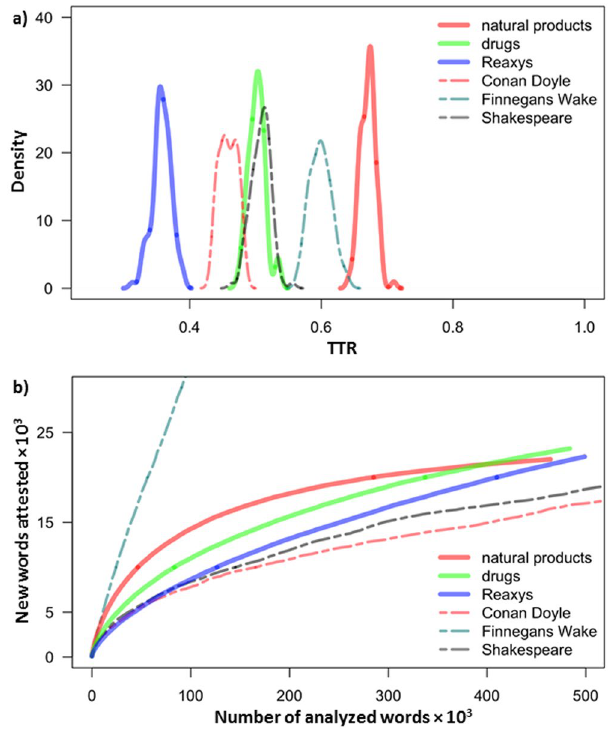
Figure 2. Measures of chemical diversity in chemistry and in literary prose. ( a ) Density (y-axis) of word windows with a given MWTTR-value (x-axis). MWTTR (Moving Window TTR) is computed by traversing the whole text with a window of a given length (here, 1,000 words). Whereas in literature the ordering of words matters, chemical collections do not have any meaningful ordering of molecules – here, the windows are sliding over molecules placed in random order (the results do not change upon reshuffling the molecules). Solid lines are for chemical collections whereas dashed lines are for literary works. ( b ) Heap’s law in language and in chemistry. The curves count the increase in the number of unique words (or MCS chemical words) encountered as one traverses a given collection. Solids lines are for sets of molecules, dashed lines are for literary works. Heap’s law for the chemicals does not depend on the choice or the order of the molecules in a collection (see Fig. S2 in the